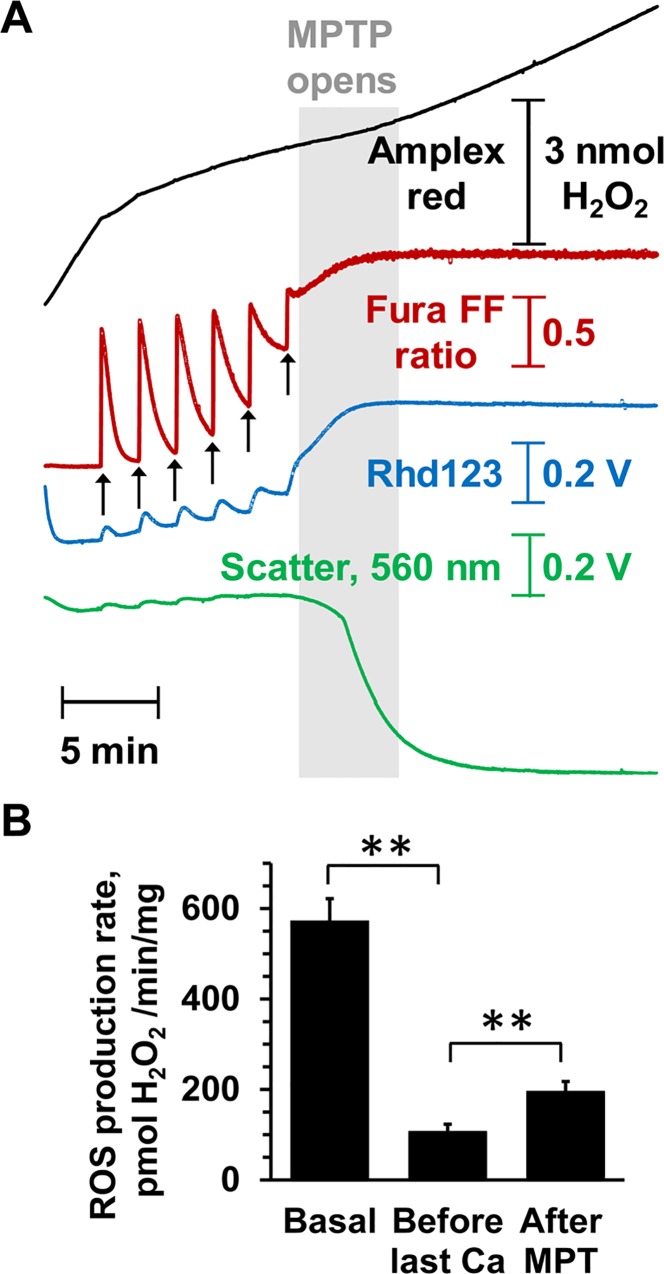
ROS production by isolated mitochondria before and after MPTP opening.A, Effects of sequential additions of Ca2+ (100 mmol/L) to isolated rat heart mitochondria incubated with 5 mmol/L L-glutamate + 2 mmol/L L-malate and 5 mmol/L succinate (GMS) on mPTP opening measured as the loss of ΔΨ (Rhd-123 fluorescence increase) or accumulated Ca2+ (Fura-FF fluorescence increase) and decrease in LS. ROS production was determined using Amplex Red in a parallel experiment on the same batch of mitochondria. B, Mean rates of ROS production (± SEM of 6 different mitochondrial preparations) before Ca2+ addition, after the penultimate Ca2+ addition and following pore opening. ** p ≤ 0.01.